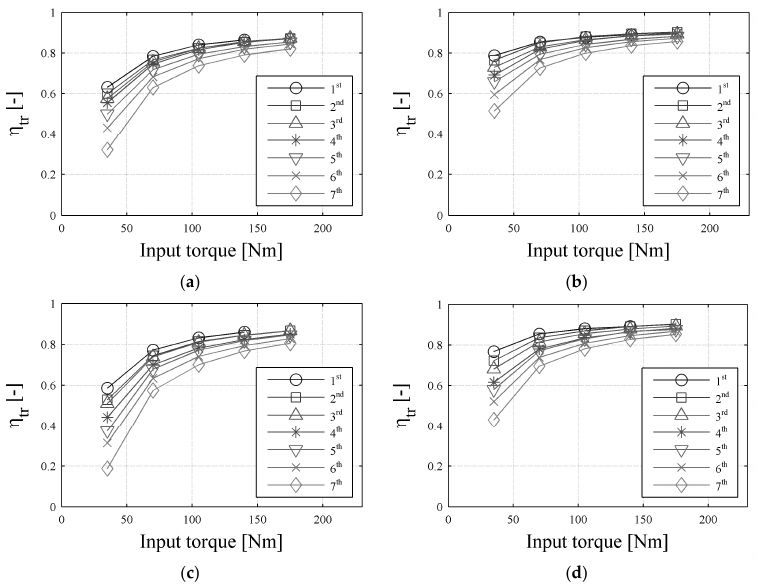
Figure 9. Sample of the experimentally measured DCT efficiency values as functions of input torque: ( a ) (cid:2033) (cid:3036)(cid:3041) = 1000 rpm, (cid:2016) (cid:3047)(cid:3045) = 30 °C; ( b ) (cid:2033) (cid:3036)(cid:3041) = 1000 rpm, (cid:2016) (cid:3047)(cid:3045) = 70 °C; ( c ) (cid:2033) (cid:3036)(cid:3041) = 2000 rpm, (cid:2016) (cid:3047)(cid:3045) = 30 °C; ( d ) (cid:2033) (cid:3036)(cid:3041) = 2000 rpm, (cid:2016) (cid:3047)(cid:3045) = 70 °C.